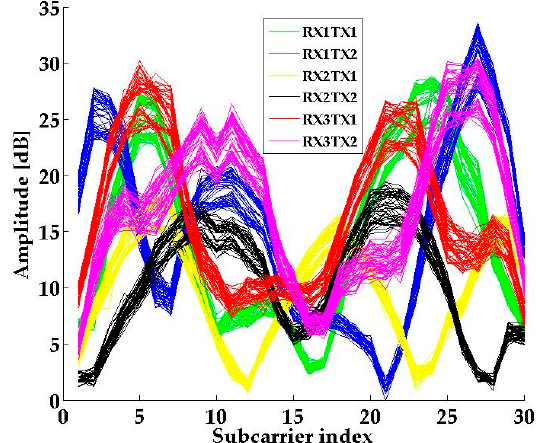
Figure 3. The CSI amplitude pattern of different antenna pairs.